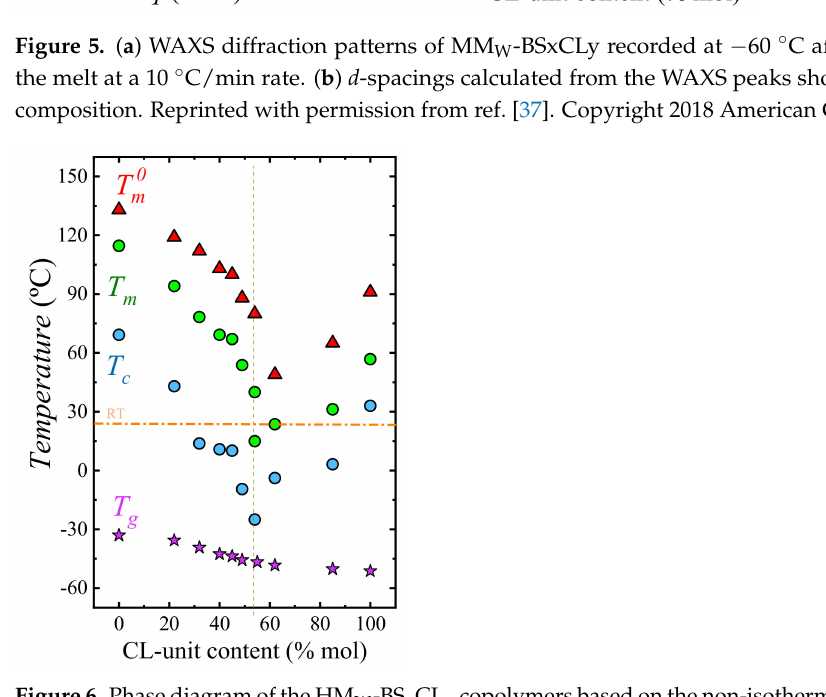
Figure 6. Phase diagram of the HM W -BS x CL y copolymers based on the non-isothermal crystallization, also showing equilibrium-melting temperatures ( T m 0 ) obtained by the Hoffman-Weeks analysis of the isothermal crystallization of samples. The short-dashed upright line specifies the pseudo-eutectic point. The dash-dotted horizontal line represents the room